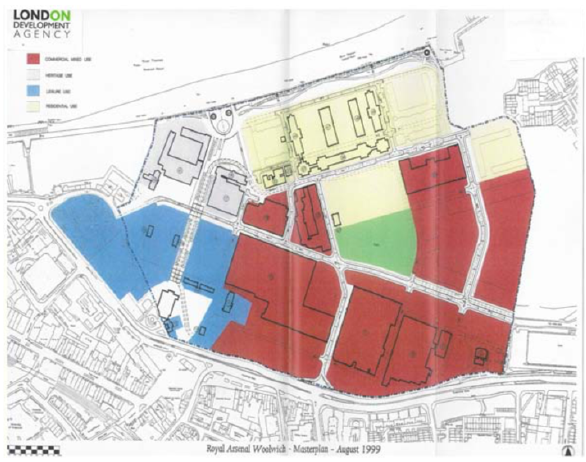
Figure 2: The masterplan from 1999